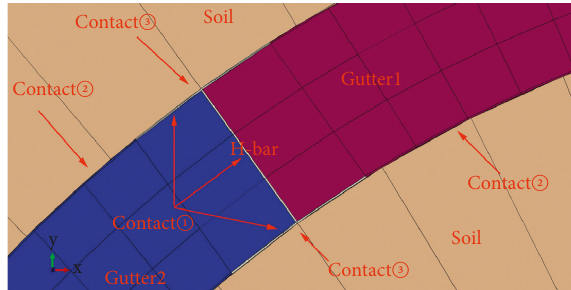
Figure 5: The distribution details of the three types of contact